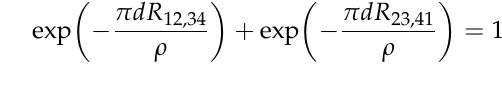
Table 2. Main photovoltaic parameters of solar cells realized with different window layers. The experimental errors are lower than 2% . -